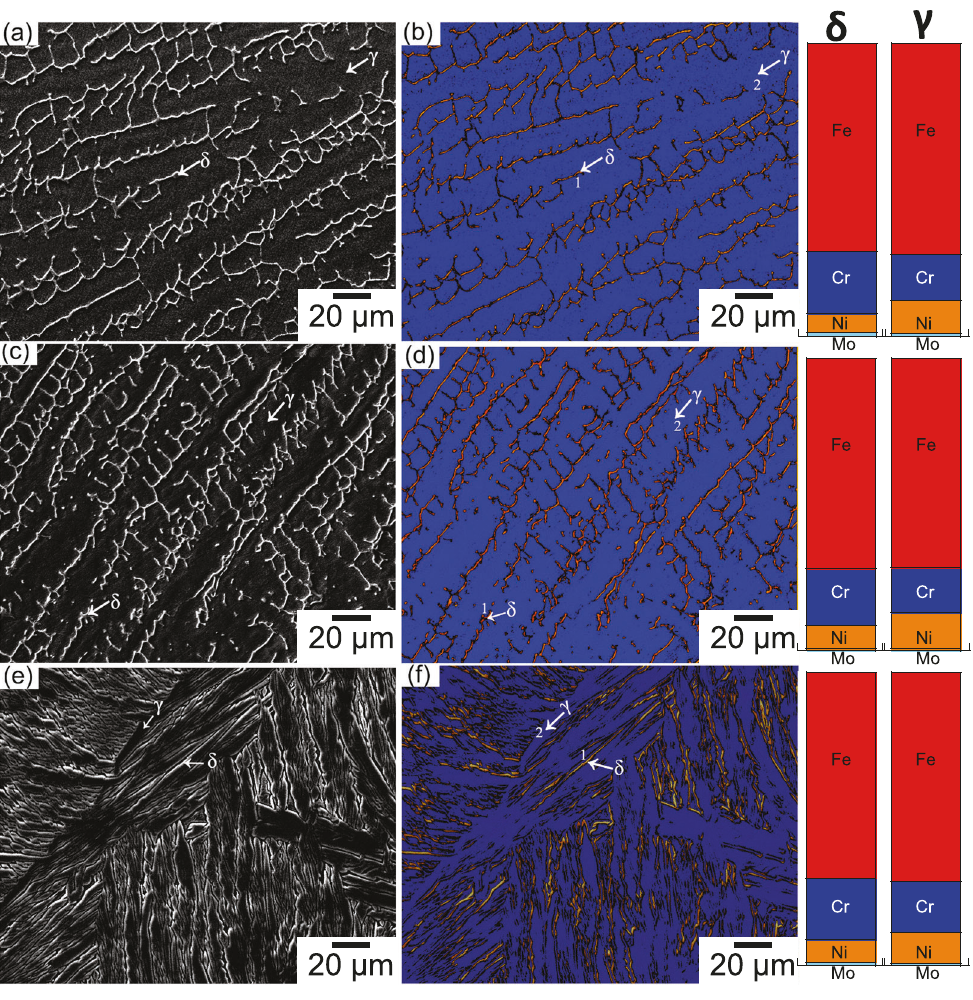
Fig. 2 Microstructure and composition. SEM micrograph and corresponding ImageJ for ( a , b ) 316L-WM, ( c , d ) 309L-WM and ( e , f ) 312-WM. Right: relative composition in wt.% of Fe, Cr, Ni, and Mo in the marked areas 1 ( δ ) and 2 ( γ ) for each of the WMs. Corresponding compositional data are in Supplementary Table